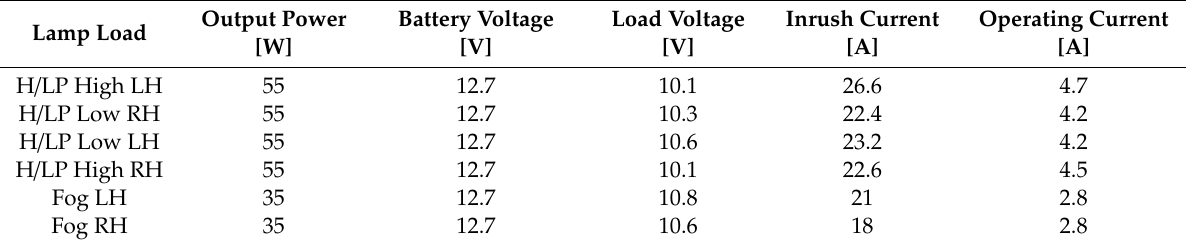
Table 4. Measured characteristics of each